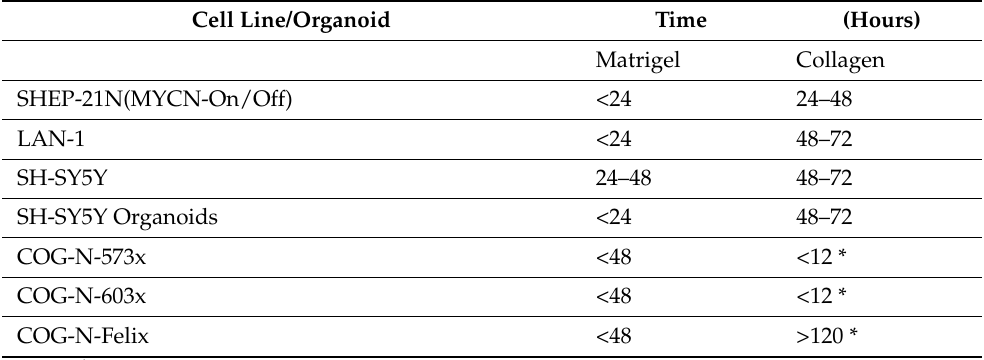
Table 2. The approximate timepoints at which NB invasion started in Matrigel and collagen